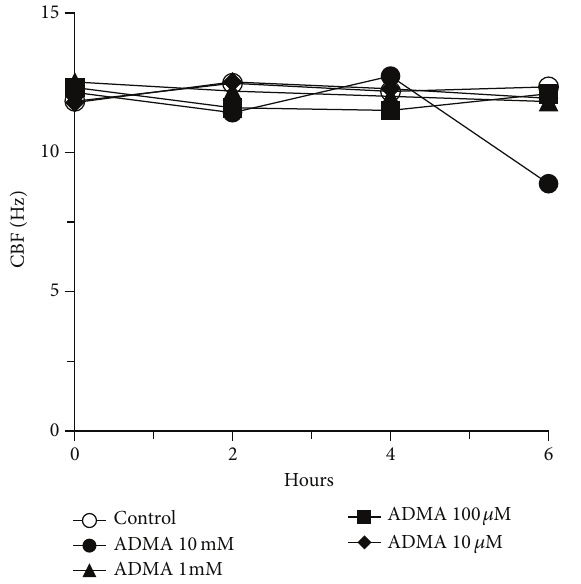
Figure 2: ADMA blocks alcohol-stimulated increases in both CBF and PKA activity in bovine bronchial epithelial cells. Cilia beat frequency (CBF) in ciliated mouse tracheal rings treated with 10 𝜇 M–10mM asymmetric dimethylarginine (ADMA) for up to 6 hr. ADMA had no effect on baseline CBF versus control media at any time point. Bars represent SEM of triplicate independent experiments ( 𝑛 = 3 mice) measuring at least 10 separate fields per experiment.